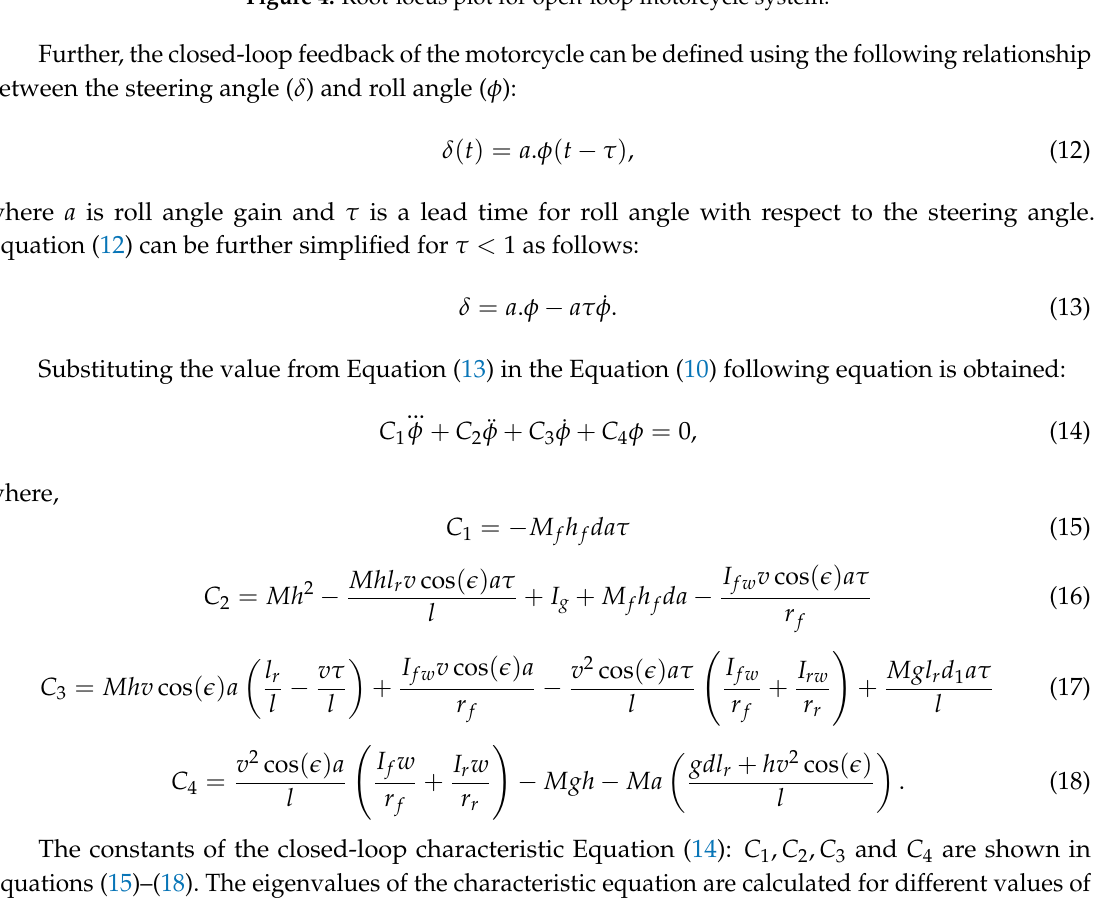
Figure 4. Root-locus plot for open-loop motorcycle